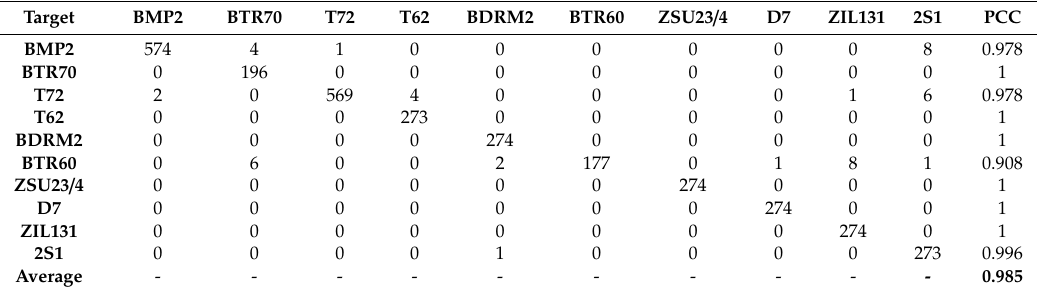
Table 8. Confusion matrix of the proposed method under the ten targets based on standard operating conditions